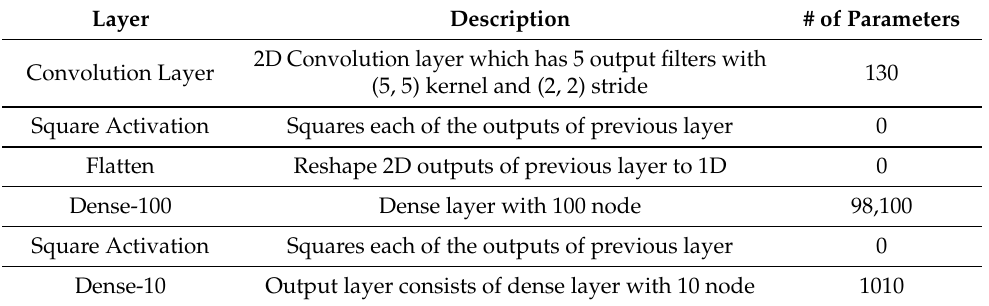
Table 1. Target model architecture for MNIST dataset.